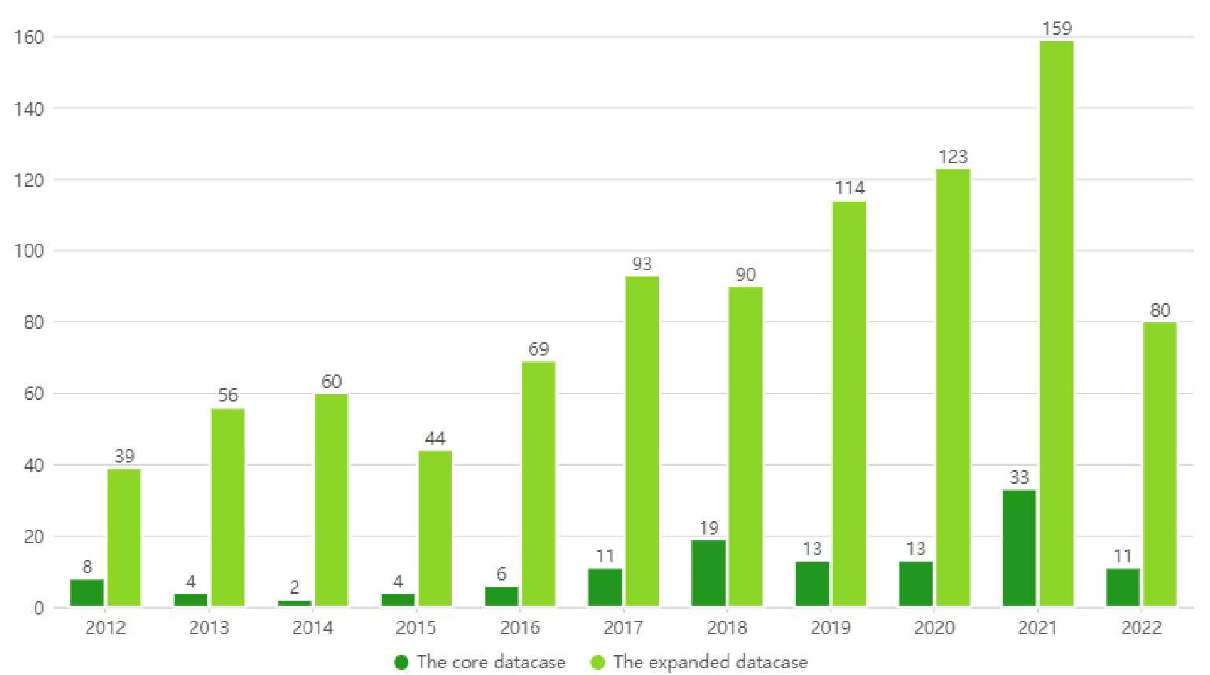
Figure 1. Annual number of publications during 2012–2022.